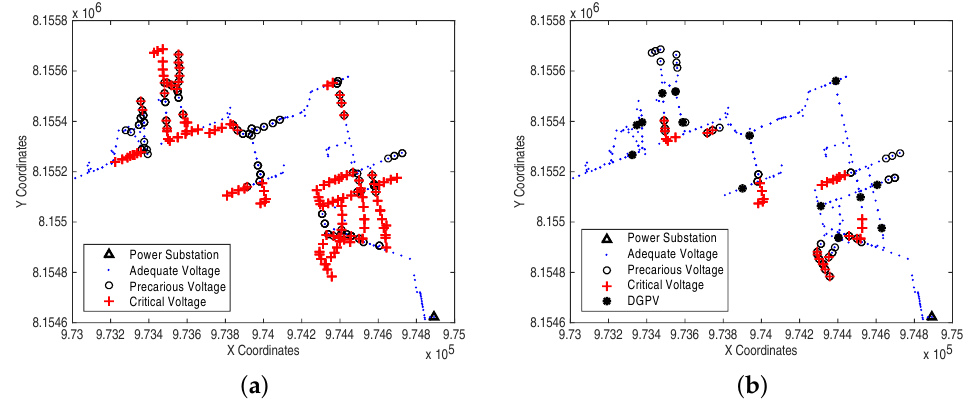
Figure 26. Result of the optimization of the variables qtd , pos , and pot without bars restriction: ( a ) voltage rating before the allocations and ( b ) voltage rating after the allocations.